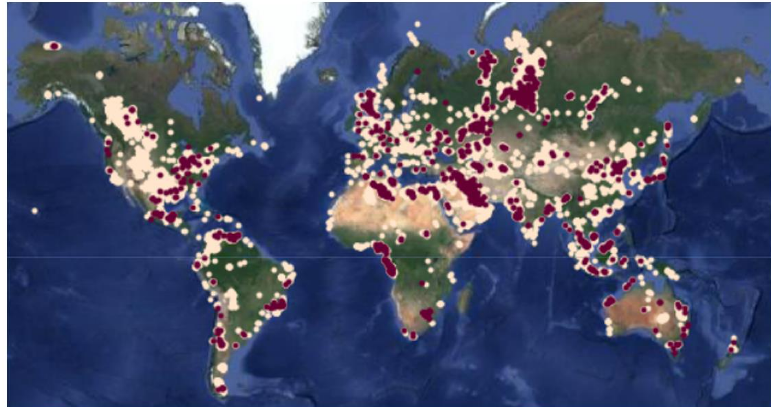
Figure 11. DAFI (purple dots) and VNF (pink dots) gas flaring sites detections. A general satisfying spatial agreement between daytime and nighttime GF datasets is evident, with the flaring regions identified by DAFI which are also captured by VNF. How- ever, the different spatial resolution, revisit interval, acquisition time and spectral bands used by the two methods make a point-by-point comparison between them impracticable (and even out of the scope of this work). On the other hand, their integration may represent an added value in terms of detection, monitoring and characterization capabilities of GF from space. Indeed, daytime and nighttime observations, if integrated, by increasing the temporal sampling, may allow for a more effective identification of the GFs. Moreover, the different GF typology and characteristics may be better revealed when different spec- tral/spatial and temporal domains are investigated. A visual investigation of DAFI and VNF maps has revealed relative performance and limitations, as put in evidence by some examples reported in Figure 12